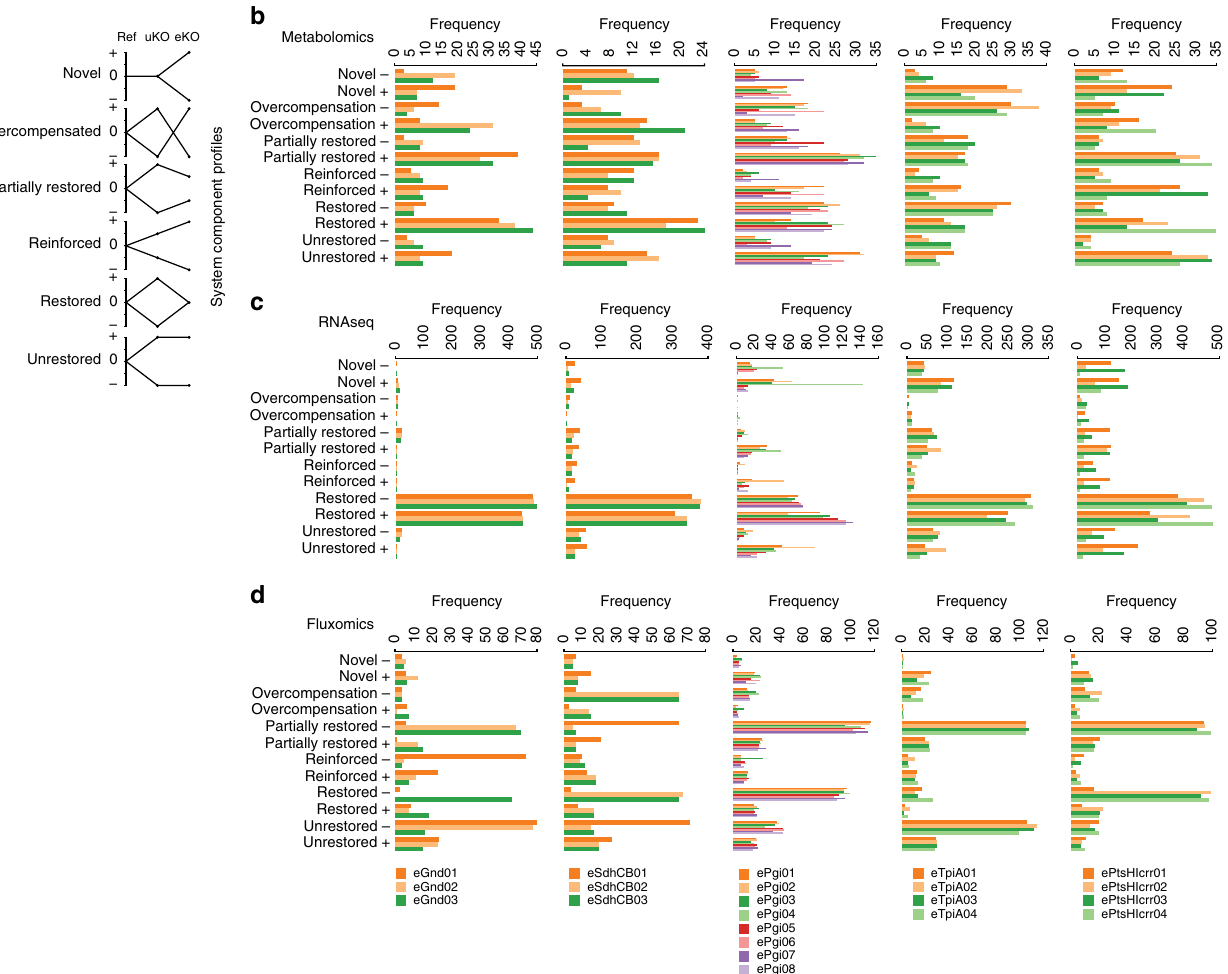
Fig. 3 Classi fi cation of changes in omics data between the reference strain (Ref), the unevolved knockout strains (uKOs) and evolved knockout strains (eKOs). a Individual components were mapped onto six pro fi les according to their abundance in the Ref, uKOs, and eKOs in both positive and negative directions. The six pro fi le types are shown and include novel, overcompensation, partially restored, reinforced, restored, and unrestored. The novel pro fi le sought to categorize system components that were changed only as a result of adaptation. The restored and partially restored pro fi les sought to categorize system components that were initially perturbed to suboptimal levels post-KO. The overcompensation pro fi le sought to categorize system components that overshot a restored pro fi le to levels even lower/higher than those in Ref. The reinforced pro fi le sought to categorize system components that needed a further increase or decrease after an initial perturbation post-KO to reach an optimal level. The unrestored pro fi le sought to categorize system components that were immediately adjusted to an optimal level post-KO and required no further adjustments during adaptation. Metabolomics ( b ), transcriptomics ( c ), and fl uxomics ( d ) data for each replicate of each KO lineage were binned into each of the six pro fi les (Pearson ’ s R , R > 0.88). See section “ Component pro fi les reveal systematic variations ” for a discussion of trends that were found based on these six pro fi